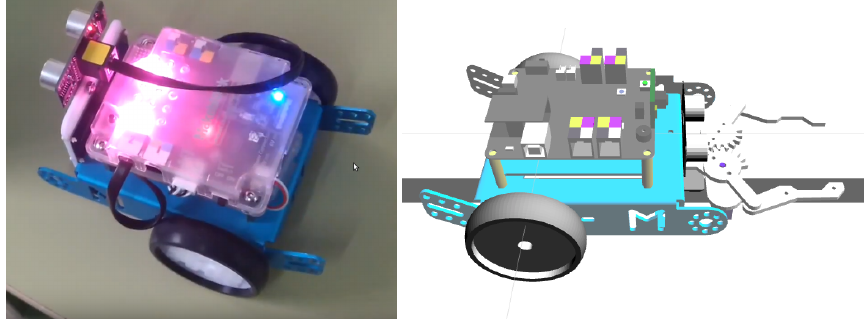
Figure 1. Robot mBot, real and simulated, in